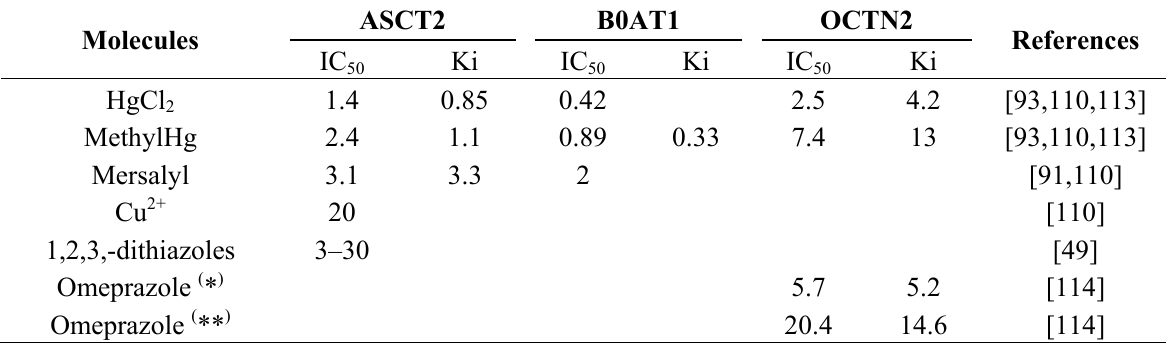
Table 2. IC values and half saturation constants of the reconstituted plasma membrane 50 transporters ASCT2, Alanine, Serine, Cysteine, Transporter 2 (ASCT2), Broad